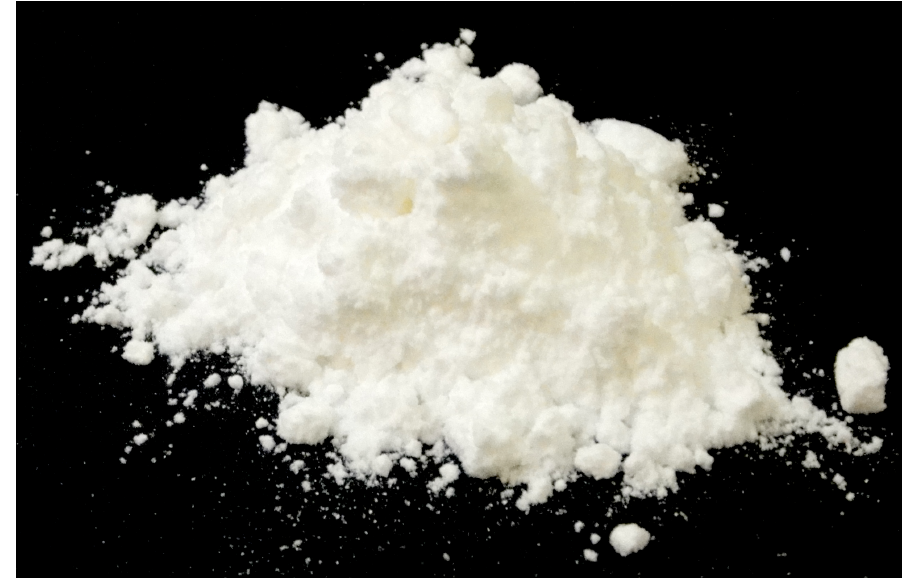
Figure 1. Microcrystalline cellulose (MCC) obtained from the hardwood cellulose raw according to the procedure described in the